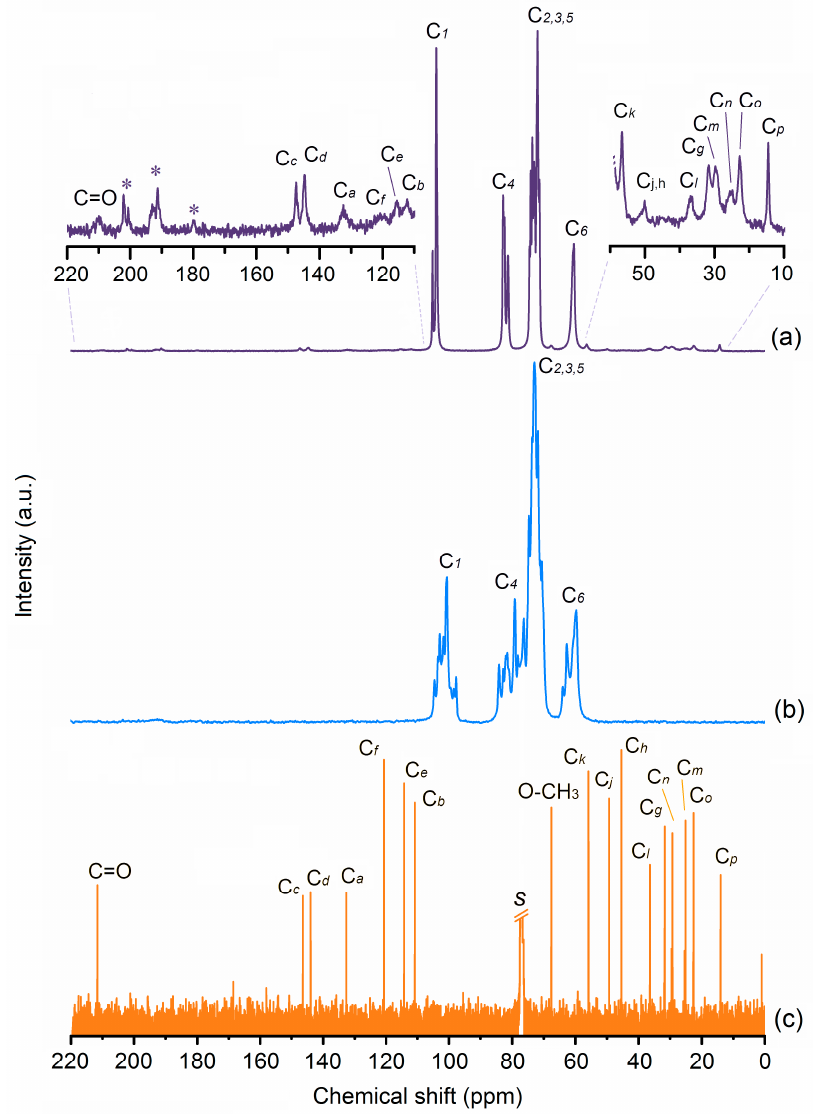
Figure 2. 13 C{ 1 H} CP/MAS NMR spectra for ( a ) γ -CD·gingerols, ( b ) the γ -CD host and